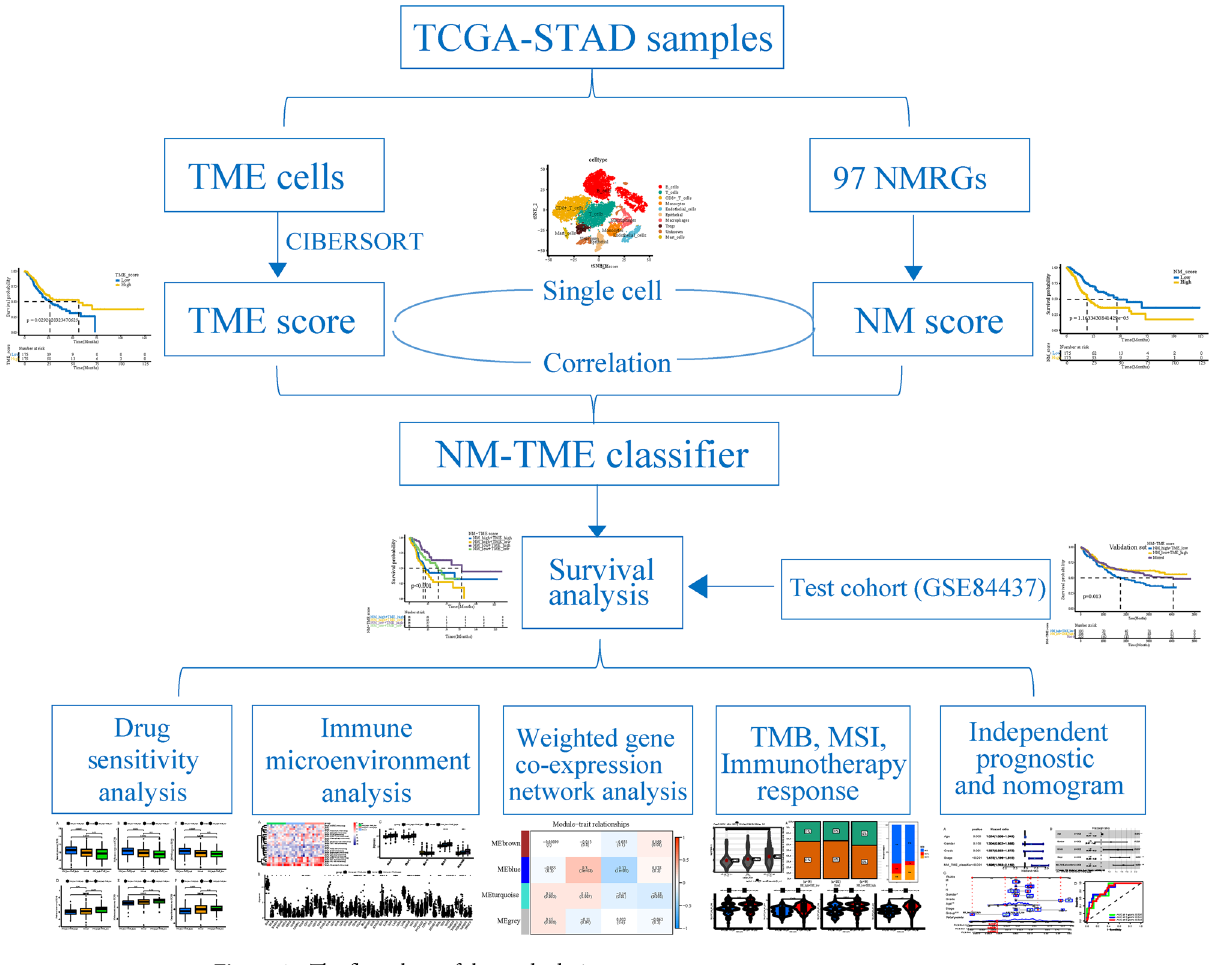
Figure 1. The flow chart of the study